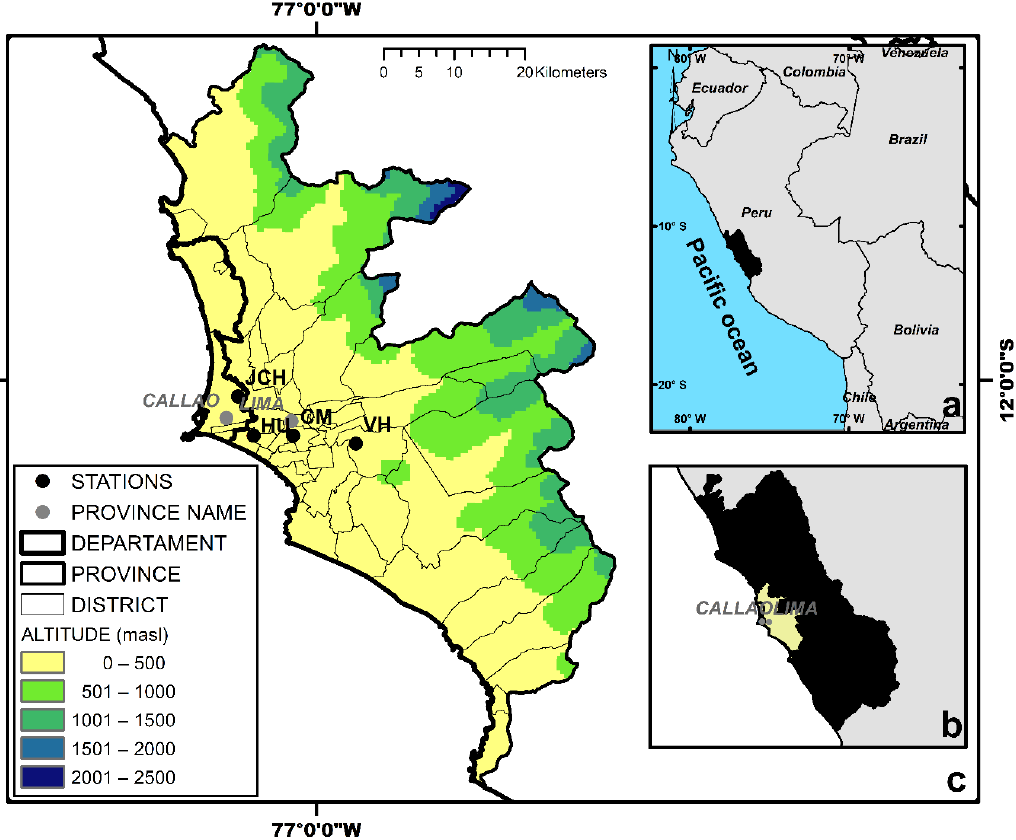
Figure 1. Location of Metropolitan Lima (ML): ( a ) South America, ( b ) Department of Lima, ( c ) Province of Lima and Callao. The black dots represent the location of the stations used in this study, and the gray dots represent the capitals of Lima and Callao.